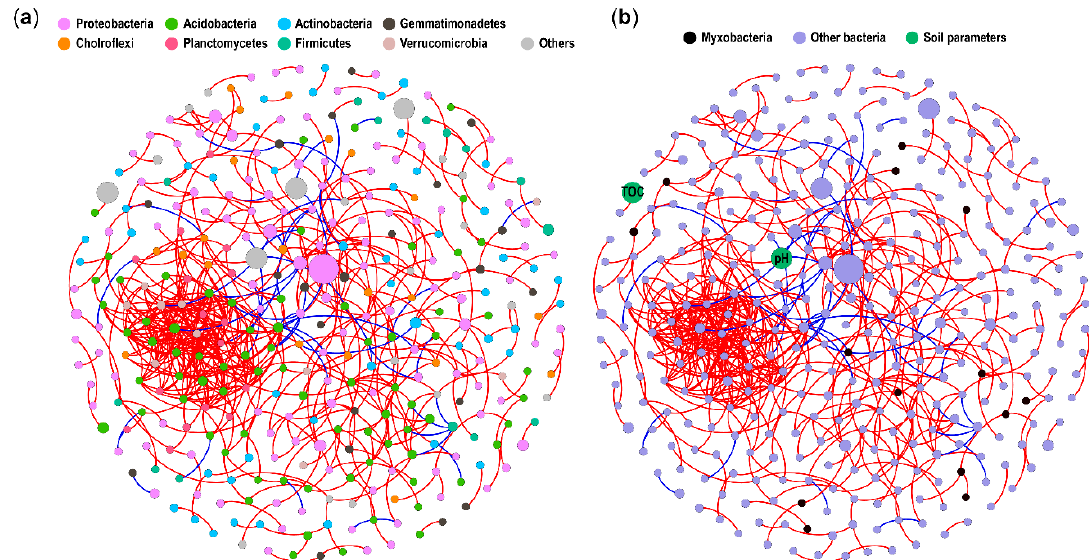
Figure 5. The co-occurrence networks showing the associations of soil myxobacteria, other bacteria and soil parameters (pH, SOM). ( a ) The nodes coded with different colors represent individual ASV and soil parameters. ( b ) The nodes coded with different colors represent myxobacteria, other bacteria and soil parameters. The edges connecting nodes correspond to statistically significant correlations between nodes and the edges in red and blue indicate positive interactions and negative interactions, respectively. Node size is the mean abundance of each ASV except the node representing soil parameter with constant size to distinguish from bacterial nodes.